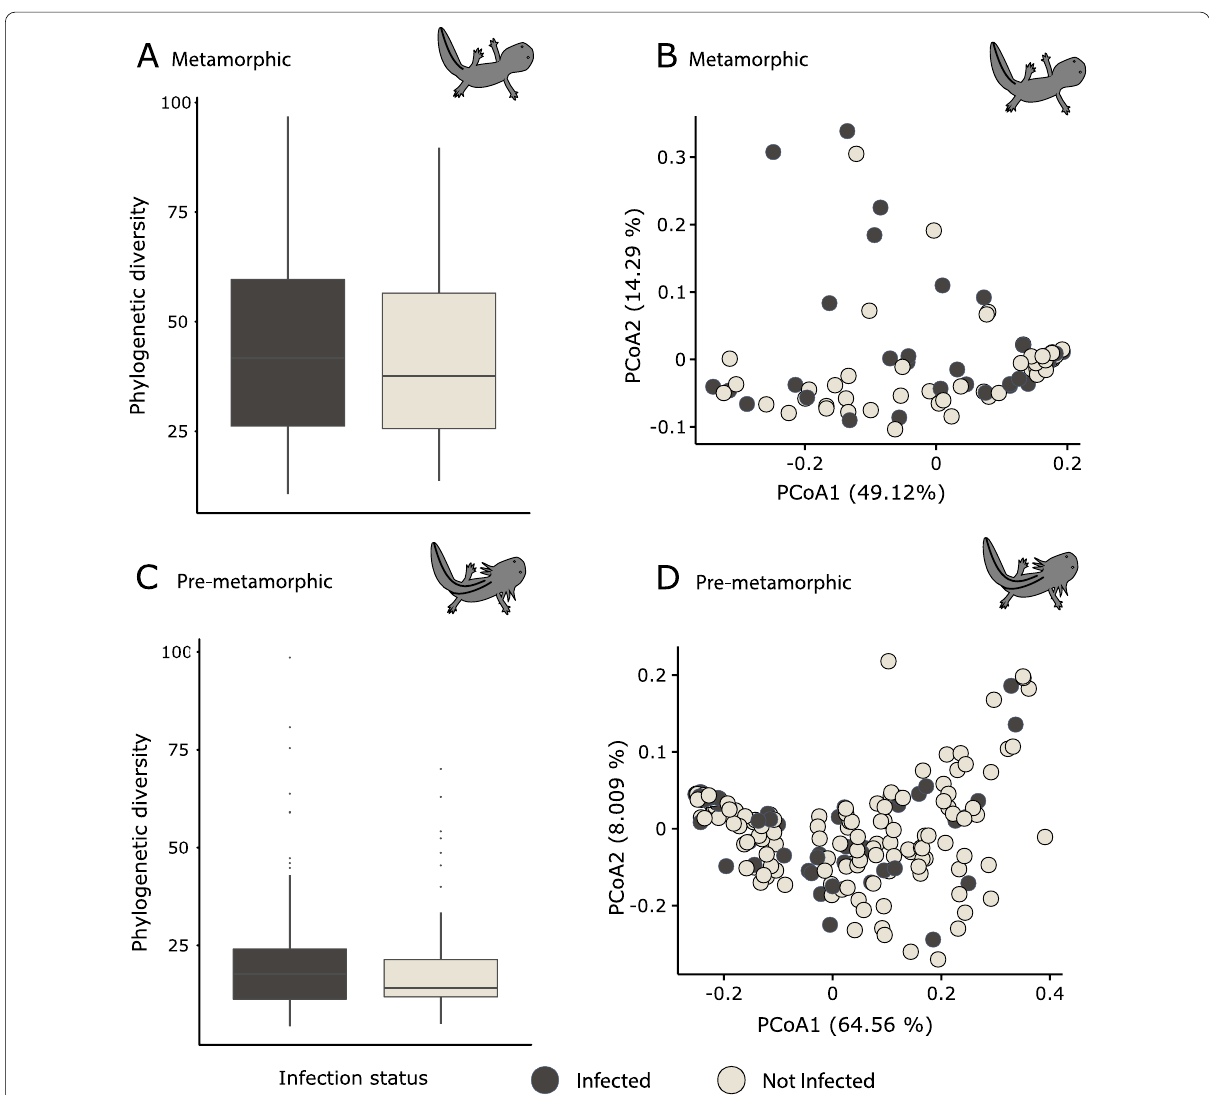
Fig. 6 A. altamirani skin bacterial diversity with respect to Bd infection status. A Alpha phylogenetic diversity (PD) between infected and non‑infected in metamorphic axolotls. B Principal coordinate analysis (PCoA) based on weighted UniFrac distances in infected vs non‑infected metamorphic axolotls. C PD between infected and non‑infected in pre‑metamorphic axolotls. D PCoA based on weighted UniFrac distances in infected vs non‑infected in pre‑metamorphic axolotls. Circles are color‑coded by Bd infection